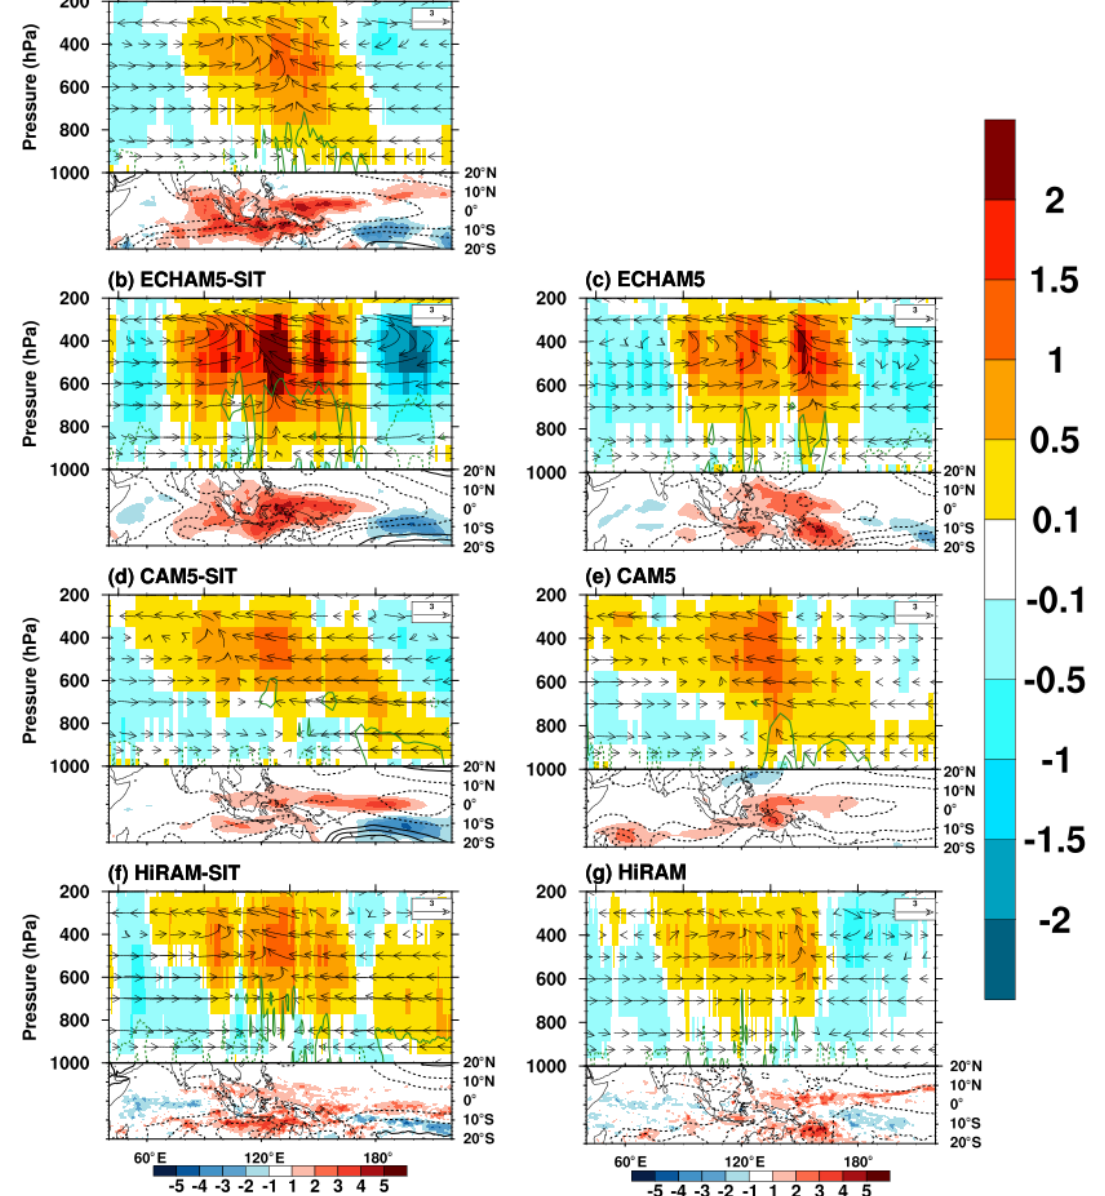
Figure 4. Structure of simulated MJO in phase 4. The longitude–height cross sections (averaged over 10 ◦ S–EQ) of the MJO-scaled wind circulation (vector, u : ms − 1 ; omega: 10 − 2 Pas − 1 ), Q1 (shading, unit: Kd − 1 ), and the horizontal moisture convergence (green contour, unit: 10 − 6 gkg − 1 s − 1 ) from (a) observations and simulations using the (b–d) coupled and (e–g) uncoupled AGCMs. The contour interval of the moisture convergence is 8 × 10 − 6 gkg − 1 s − 1 ; the solid line indicates positive values. Precipitation (shading, unit: mmd − 1 ) and sea level pressure (contour, unit: hPa) are also shown. The contour interval of sea level pressure is 30hPa; the dashed line indicates negative